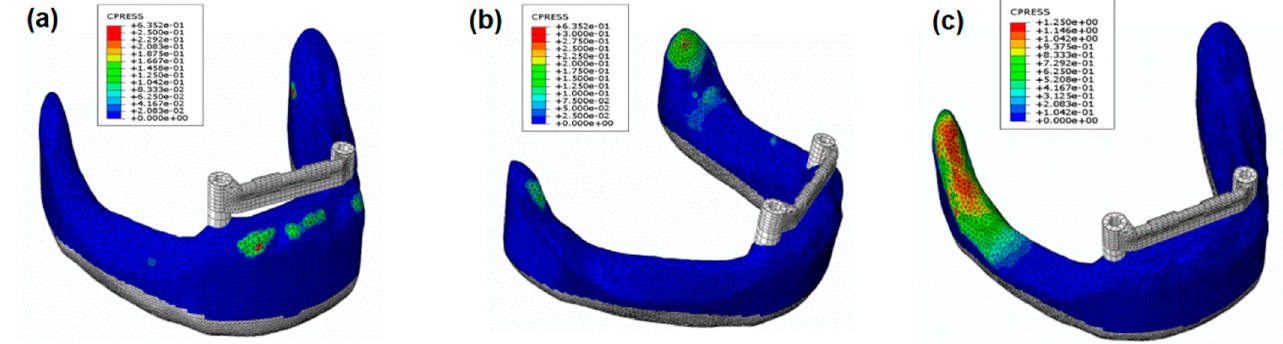
Figure 9. Contact stress distribution over gingiva after the application of the matrices of 2.5 MPa Young’s modulus and for three load cases: biting force on ( a ) incisor, ( b ) canine, and ( c ) molar.